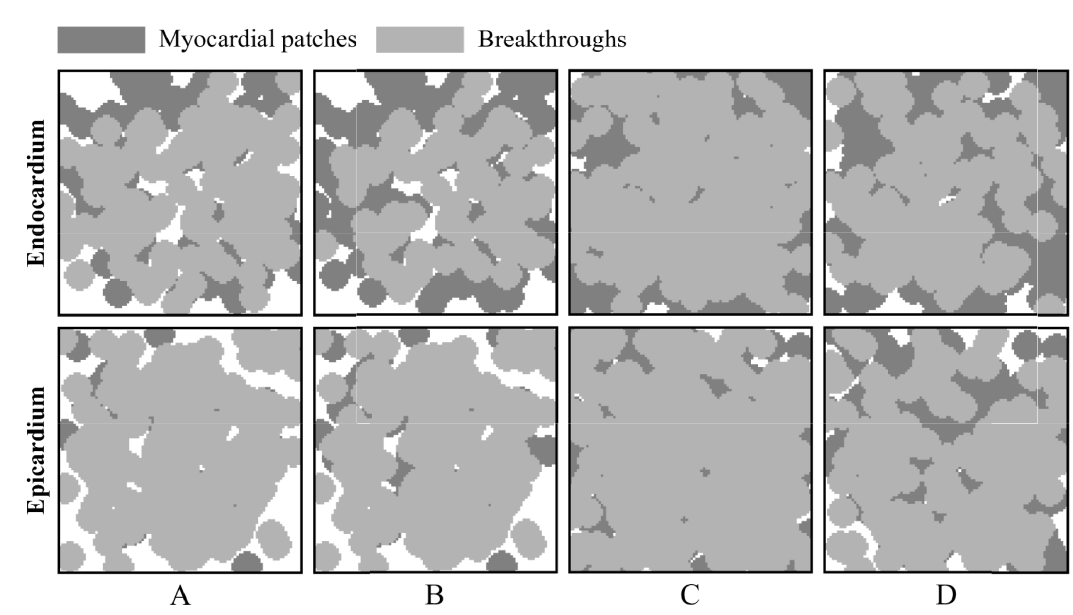
Fig 14. Location distributions of breakthroughs in the stochastic group. The results are extracted from (A) 23 stable simulations during the whole duration, (B) 23 stable simulations during the first 3 seconds, (C) 42 non-stable simulations, and (D) 27 non-stable simulations with the duration less than 3